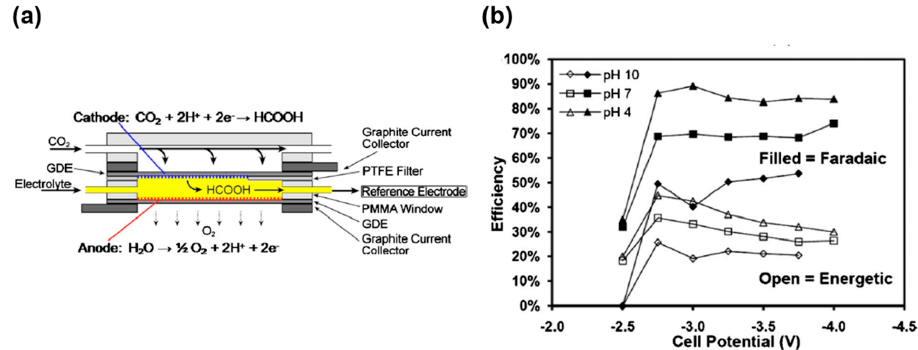
Figure 11. ( a ) Microfluidic type reactor cell. ( b ) Plot of Faradaic efficiency of formate production with Sn catalysts with regard to pH condition. Reprinted with permission from the authors of [27].